Question: Which visualization type does this figure use?
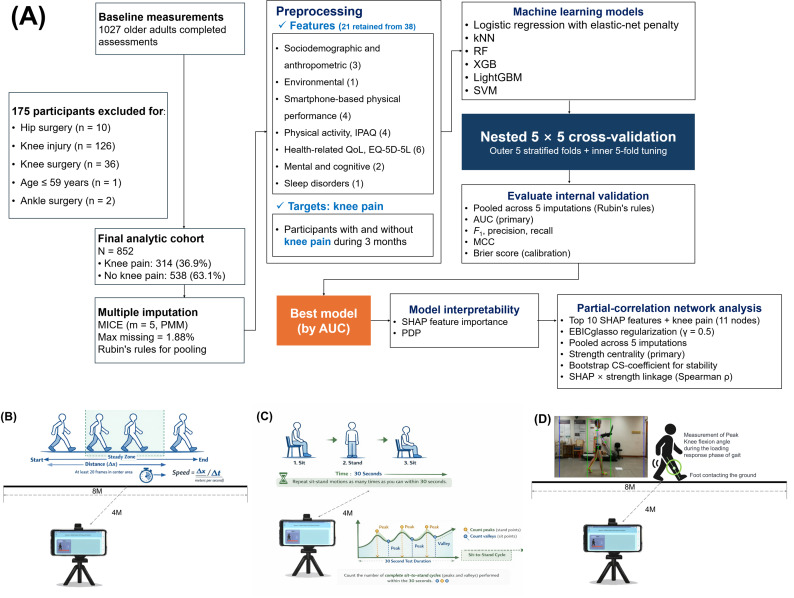
Answer: line